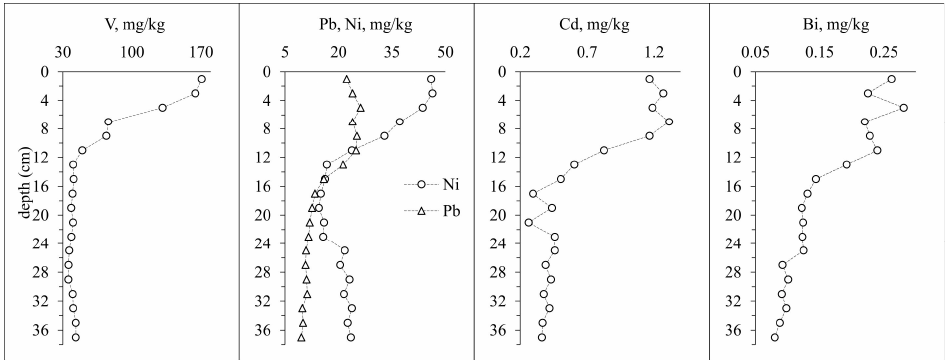
Figure 13. The vertical distribution of heavy metals in sediments of Vygozero Reservoir (Republic of Karelia) [69].